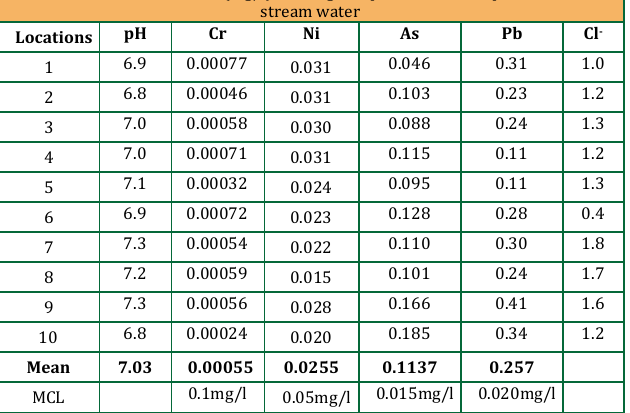
Concentrations (mg/l) of inorganic parameters and pH values in stream water